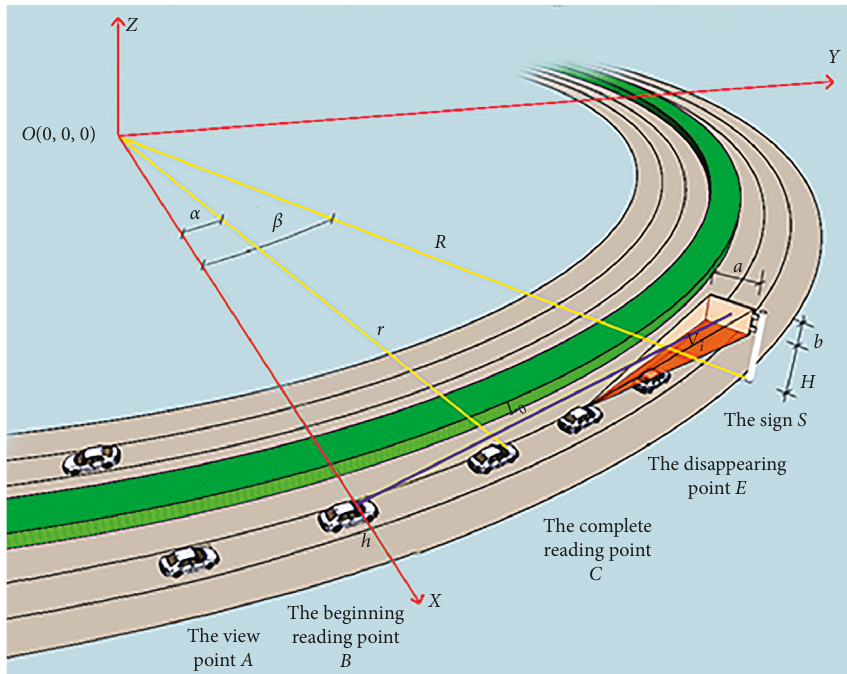
Figure 1: The visual occlusion of traffic sign on the curved highway (for details, refer to the